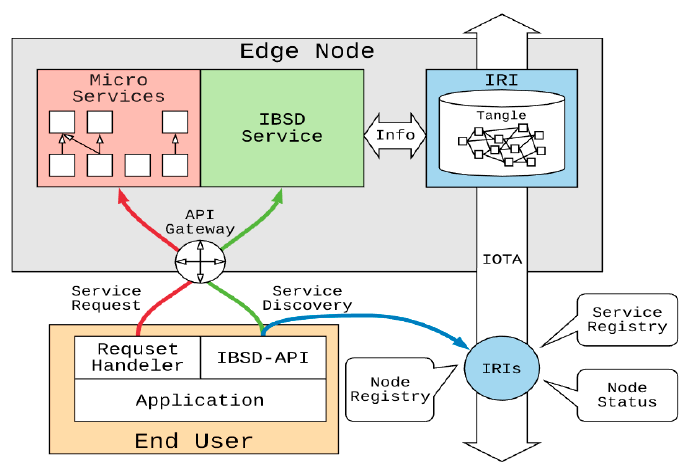
Figure 2. The architecture of IOTA-based service discovery (IBSD) .